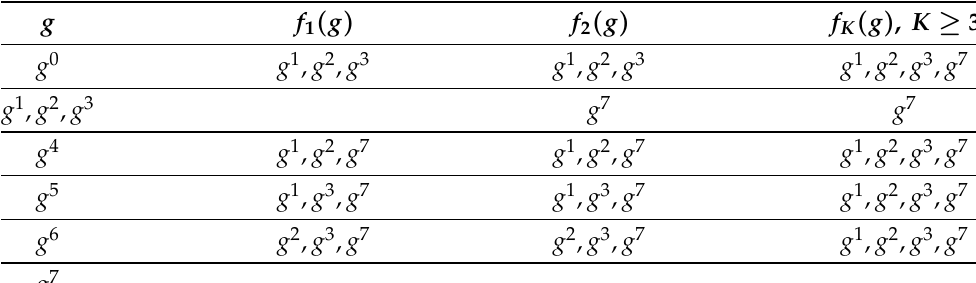
Table 1. The elements of f K ( g ) \ { g } for 3-player criminal networks with B = 9 and φ = 1. g f 1 ( g